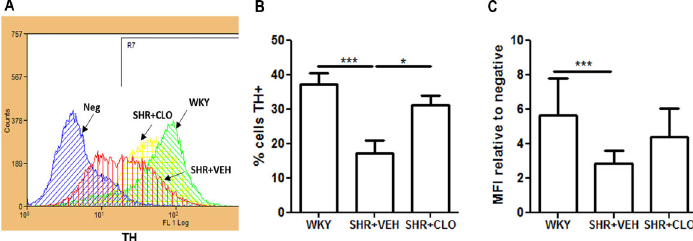
Figure 2. Representative histograms of tyrosine hydroxylase (TH) labeling ( A ). Quanti fi cation of the percentage of leukocytes expressing TH ( B ) and the median fl uorescence intensity (MFI) ( C ) of TH labeling in total leukocytes from WKY, SHR + VEH, and SHR + CLO groups. Data are reported as means ± SD for n=10 animals/group. *P o 0.05 and ***P o 0.0001 (one-way ANOVA). WKY: normotensive Wistar Kyoto rats; SHR: spontaneously hypertensive rats; VEH: vehicle; CLO: clonidine.